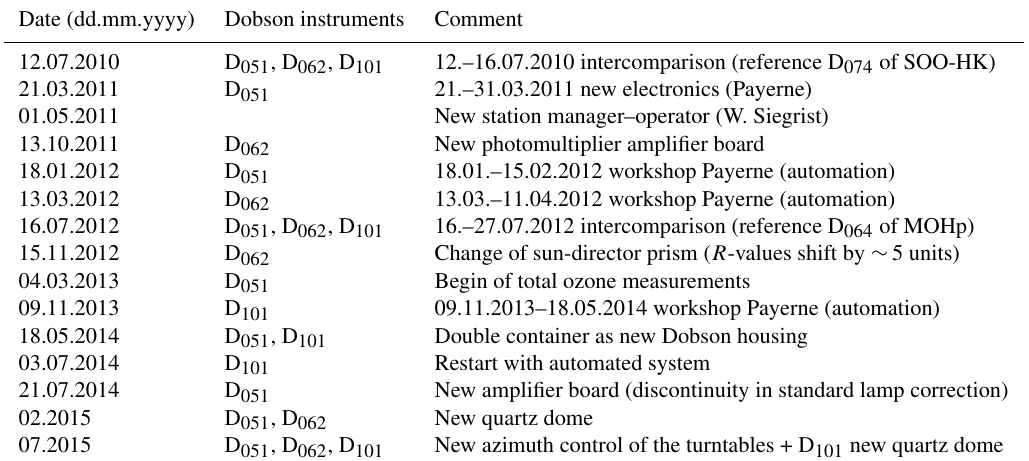
Table 1. Chronology of the interventions and calibrations of the three Dobson instruments over the transition period 2010–2015 from manual to automated Dobson operation.